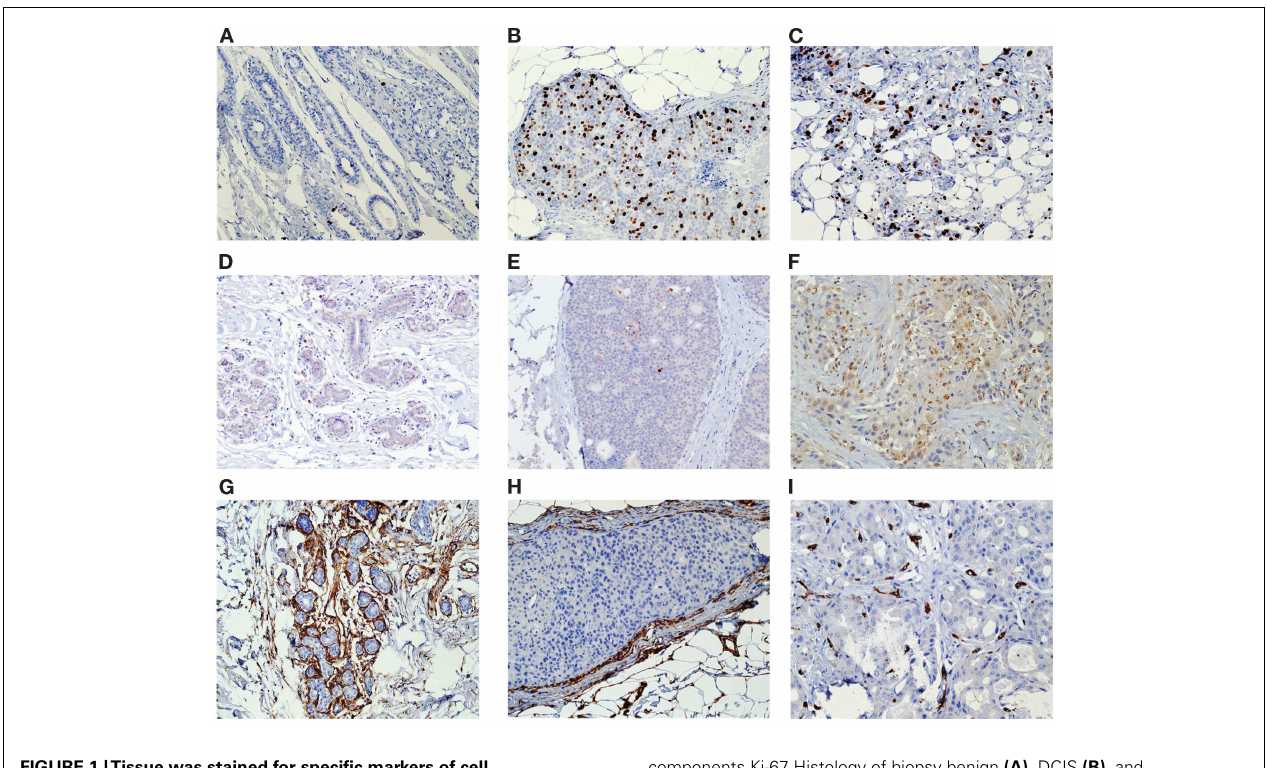
FIGURE 1 |Tissue was stained for specific markers of cell proliferation (Ki-67), apoptosis (casp-3), and angiogenesis (CD34) using the respective antibodies . Separate IHC analyses were performed on the benign and malignant (DCIS and invasive) breast cell